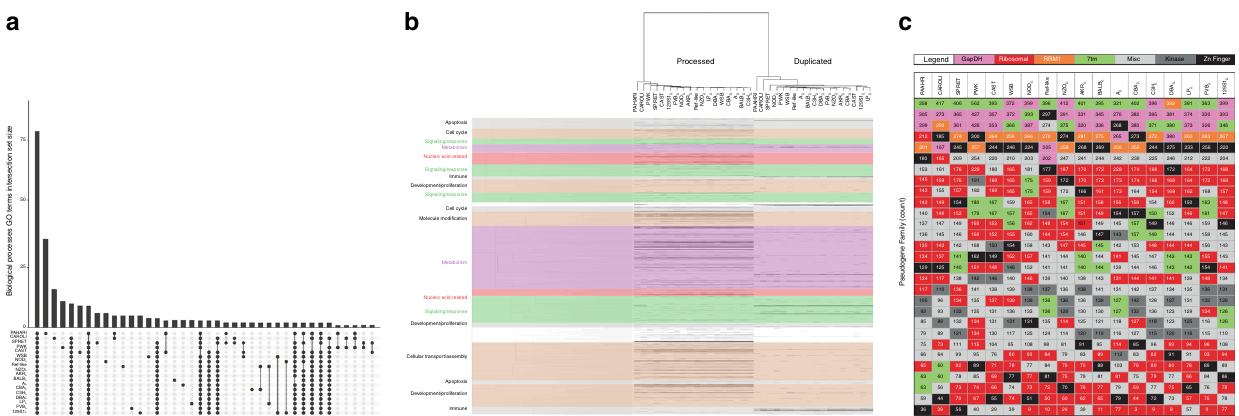
Fig. 6 Functional analysis of pseudogenes. a Distribution of enriched GO biological processes terms across the mouse strains. Associated data is available in Supplementary Data 5. b Heatmap illustrating enrichment of GO biological processes terms across the mouse strains for the parent genes of processed and duplicated pseudogenes. GO terms (rows) are clustered by semantic similarity (colour). Each line in the heatmap indicates the presence of an enriched GO term associated with a strain ’ s pseudogene complement. The GO terms shown in colour indicate an association with the pseudogene family of similar colour in ( c ). c Summary of the top 24 Pfam pseudogene families in each mouse